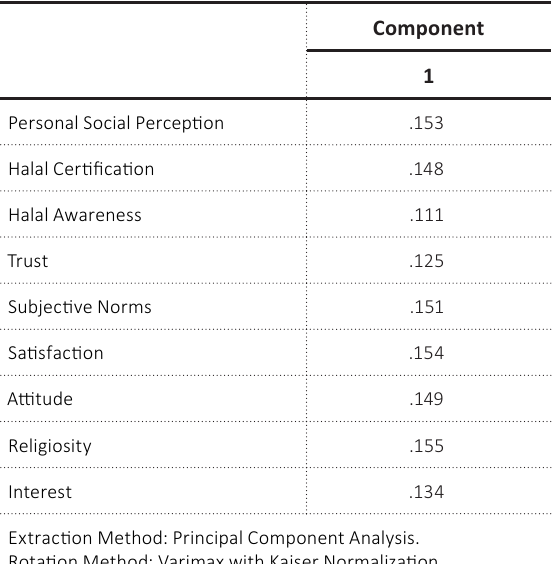
Tabel 6. Rotated component matrix a